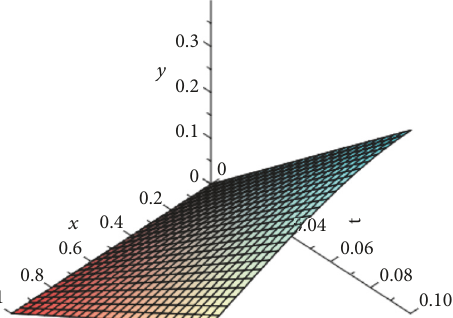
Figure1:Numericalsolutionfor(22)usingVIMBwhenn=m=2and